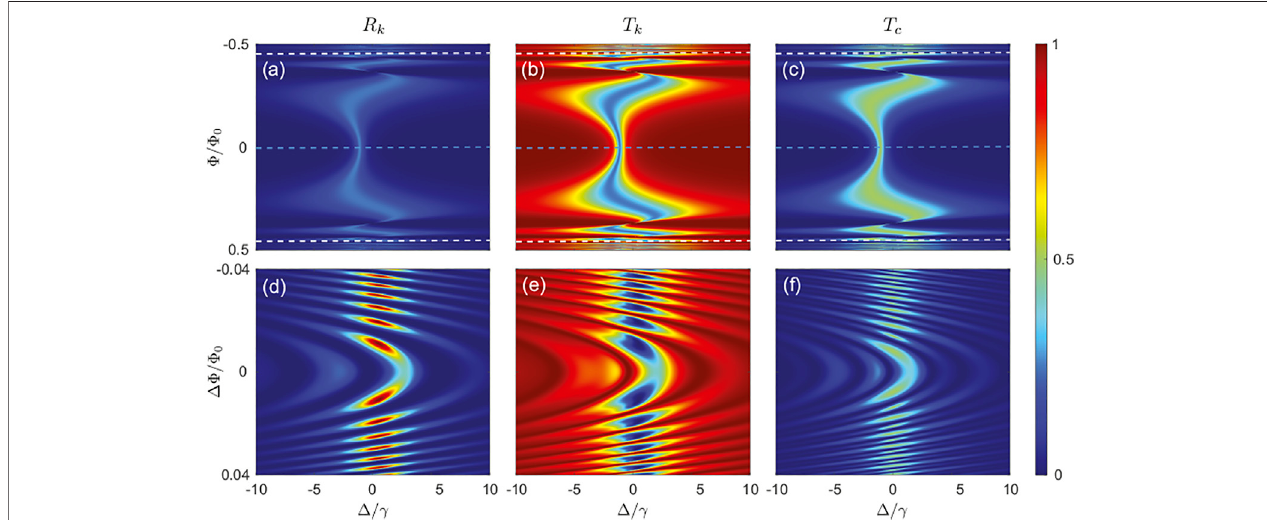
FIGURE 3 | Density plots showing the single-photon (A,D) re fl ection rate R k (B,E) transmission rate T k , and (C,F) frequency conversion rate T c as a function of the detuning Δ / γ and fl ux Φ / Φ 0 . In (A – C) , the variation range of Φ is setted to be − 0.5 Φ 0 ~ 0.5 Φ 0 while (D – F) is − 0.04 Φ 0 + Φ a ~ 0.04 Φ 0 + Φ a with Φ a satisfying (cid:3)(cid:3)(cid:3)(cid:3)(cid:3)(cid:3)(cid:3)(cid:3)(cid:3)(cid:3)(cid:3)(cid:3) (cid:4) γ T (cid:1) γ T (cid:1) cos ( π Φ a / Φ 0 ) a 0 /